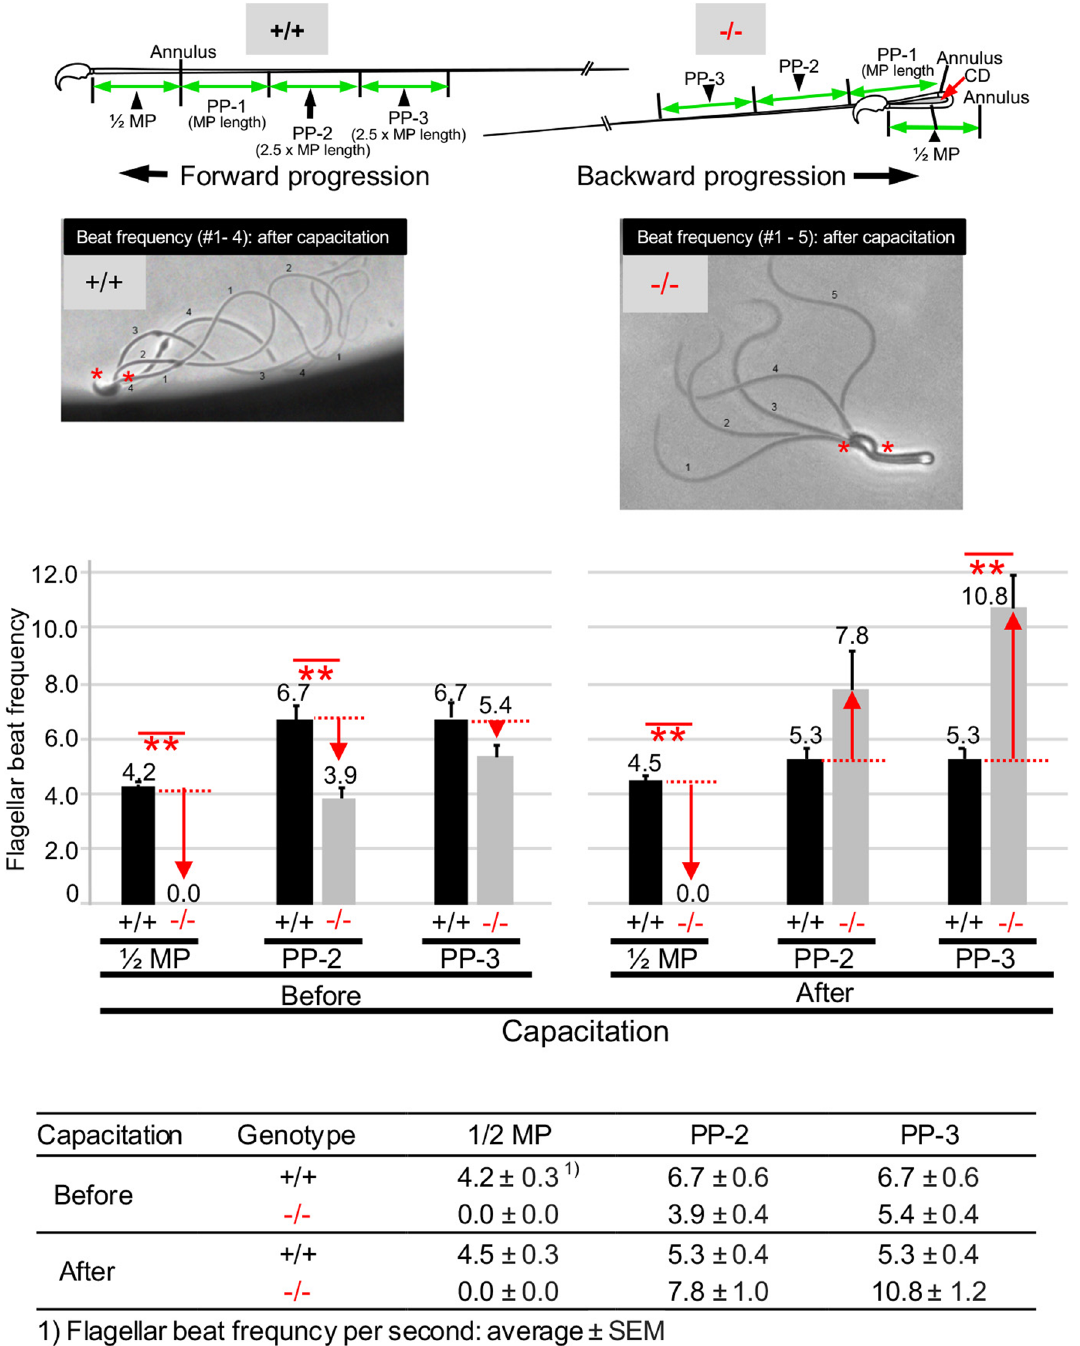
Figure 6. Flagellar beat frequency. + / + : Odf4 +/+ . −/−: Odf4 −/− . Sperm activation (capacitation) was performed in TYH medium. The data are obtained from video and images analyzed using Premier Pro software (see Methods). (Top) Schematic images showing 3 positions of the flagellum for calculation: 1/2 MP (midpiece), PP (principal piece)-2 and PP-3 (arrowheads), where MP length is the distance from the neck to the annulus (approximately 22 μm). 1/2 MP = 1/2 × MP length. Below the schemes, representative still images analyzed are shown; the corresponding videos are shown in Videos S3 and S4. Midpiece movement is active with a symmetrical pattern in Odf4 +/+ but immotile in Odf4 −/− . Principal piece movement is active in both Odf4 +/+ and Odf4 −/− . The anteriormost and posteriormost regions of the head (*) were fixed at the same position during each analysis. (Middle) Graphs for flagellar beat frequency per second. Odf4 +/+ flagellar movement is almost constant and regular: 4.2 and 4.5 at 1/2 MP and 6.7 and 5.3 at both PP-2 and PP-3 before capacitation and after capacitation, respectively. In contrast, in Odf4 −/− , the midpiece is essentially immotile with null values (0.0), but the distal principal piece actively moves before capacitation and after capacitation with high values; the beat frequency is more active after capacitation (7.8 in PP-2 and 10.8 in PP-3) than before capacitation (3.9 in PP-2 and 5.4 in PP-3). Mann ‒ Whitney U test (two-tailed analysis) for + / + vs. −/− 1/2 MP before capacitation and after capacitation. Student’s t test (two-tailed analysis) for + / + vs. −/− PP-2 before capacitation and + / + vs. −/− PP-3 after capacitation. (Bottom) The table shows raw data. N males ( N sperm): 4 (11) and 4 (14) for Odf4 +/+ and Odf4 −/− before capacitation and 6 (17) and 4 (8) for Odf4 +/+ and Odf4 −/− after capacitation, respectively. ** P <